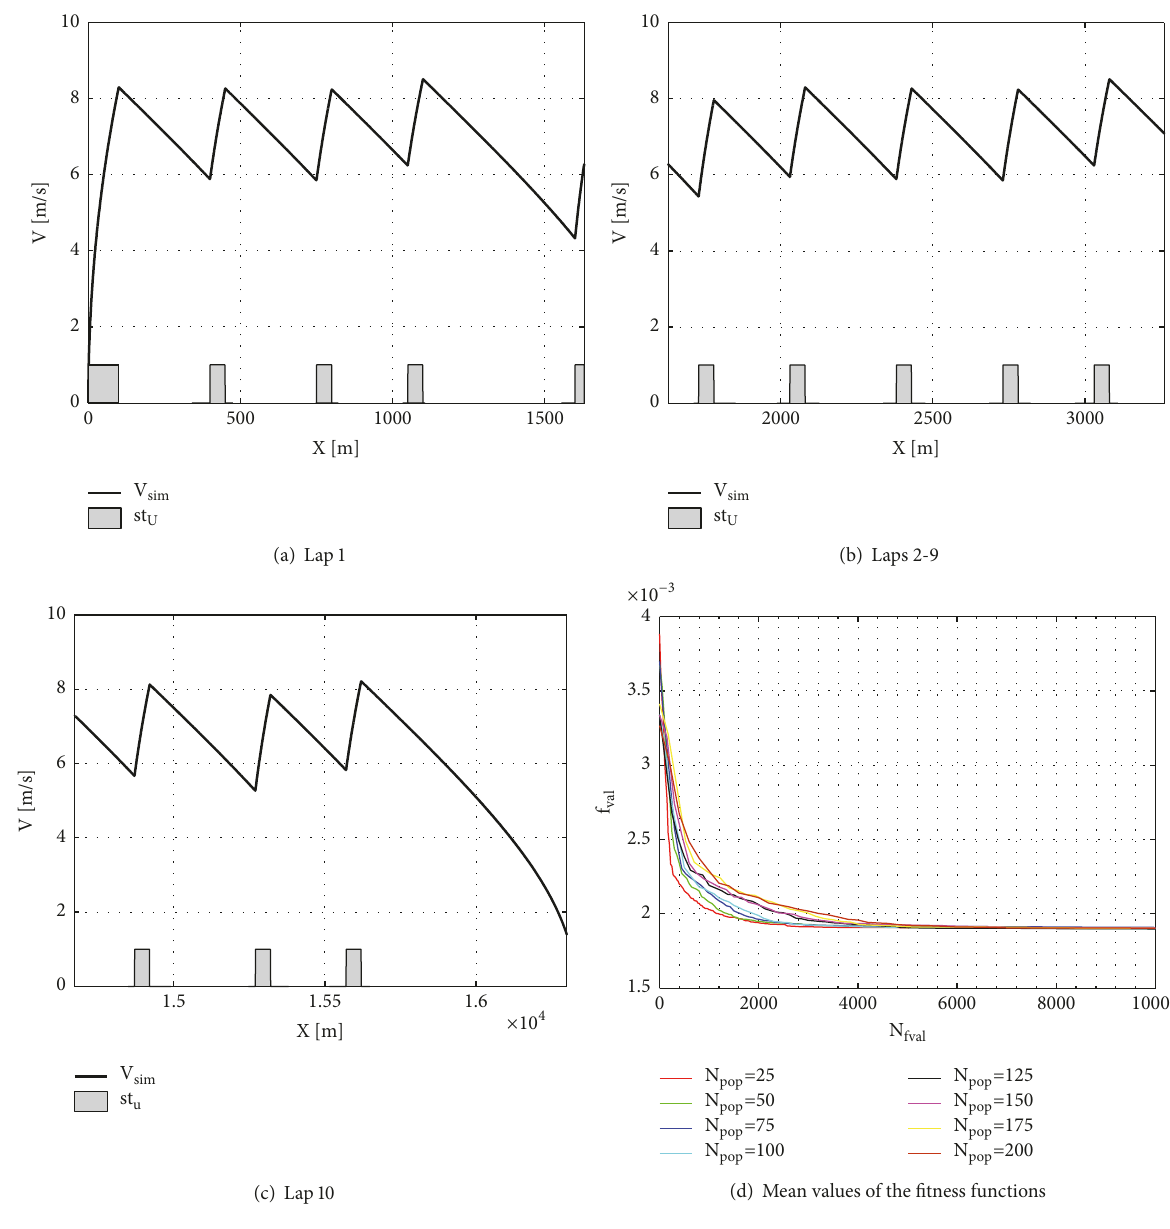
Figure 17: Vehicle speed and control signal st 𝑈 for route 1. Table 6: The results for route